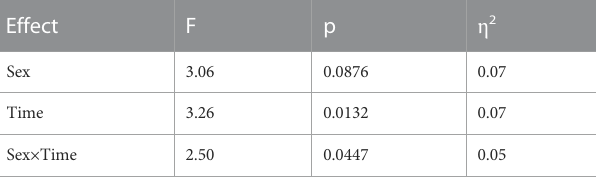
TABLE 2 Main effects and interaction effects of sex and time changes in absolute approach ( Δ cm). Two-way repeated measures